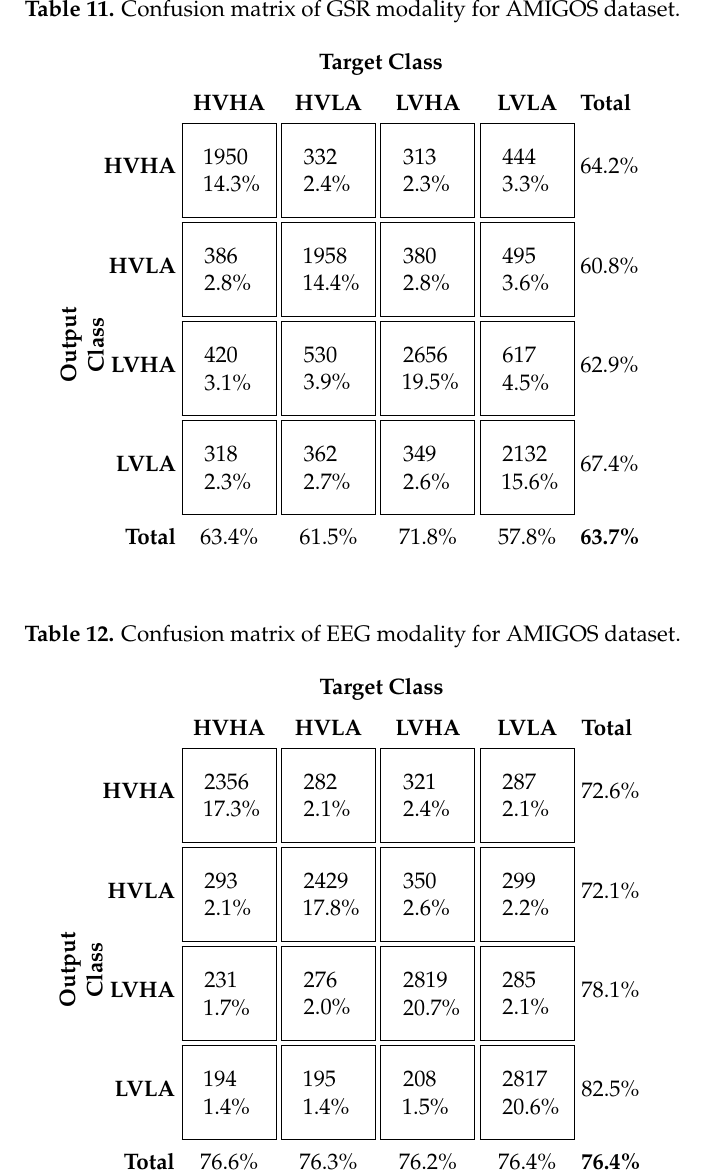
Table 11. Confusion matrix of GSR modality for AMIGOS dataset.